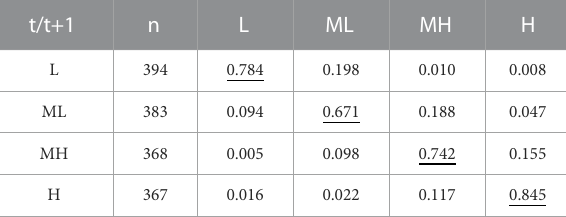
TABLE 5 Traditional Markov transfer probability matrix of ULGUE in the Yangtze River Economic